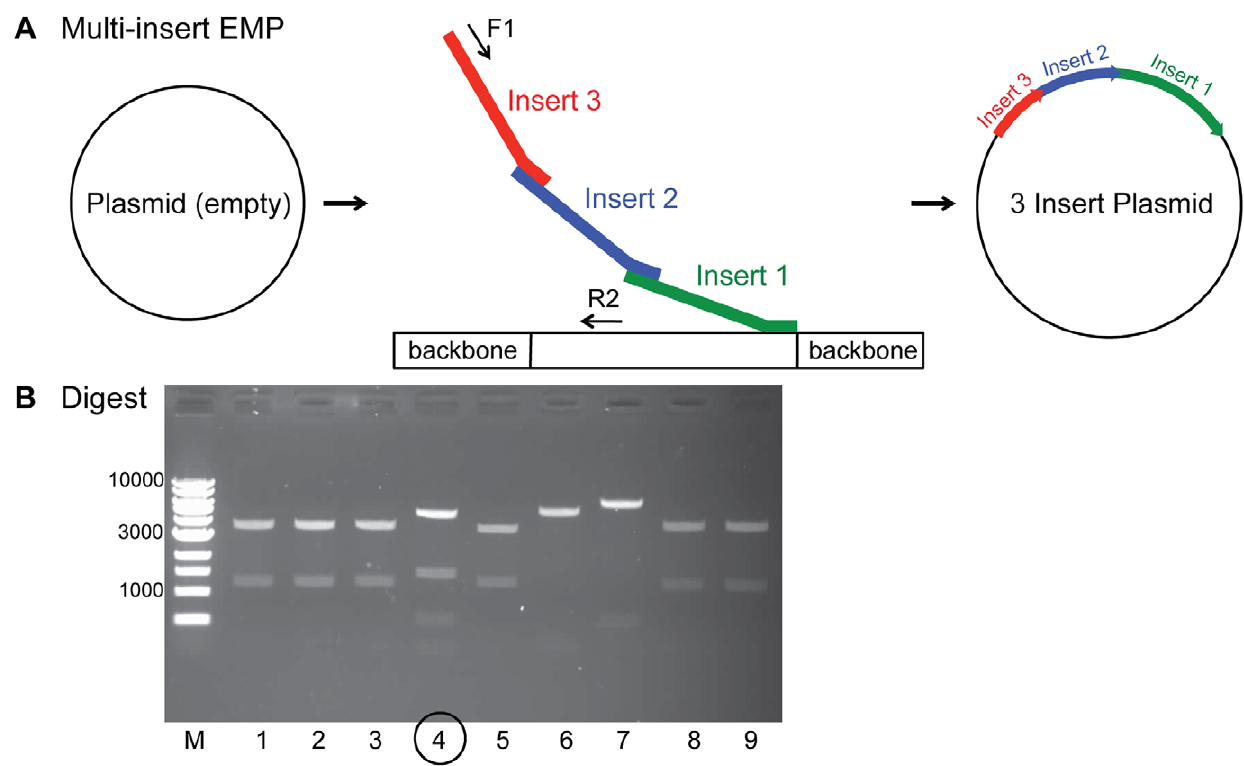
Figure 6. Applications of EMP cloning: Multi-insert EMP. EMP cloning allows for insertion of several megaprimers at once. (A) In a multi-insert EMP megaprimer 3 9 overhangs are designed such that they bind in nested manner. The terminal insert (insert 1) then binds to the plasmid backbone 3 9 of the insertion site. In an exponential amplification reaction forward primer F1 binds to the beginning insert (insert 3) ensuring that all inserts are getting amplified. Reverse primer R2 binds 5 9 of the insertion site. (B) A test digest of nine colonies obtained by multi-insert EMP of three inserts shows one correct clone (number 4).